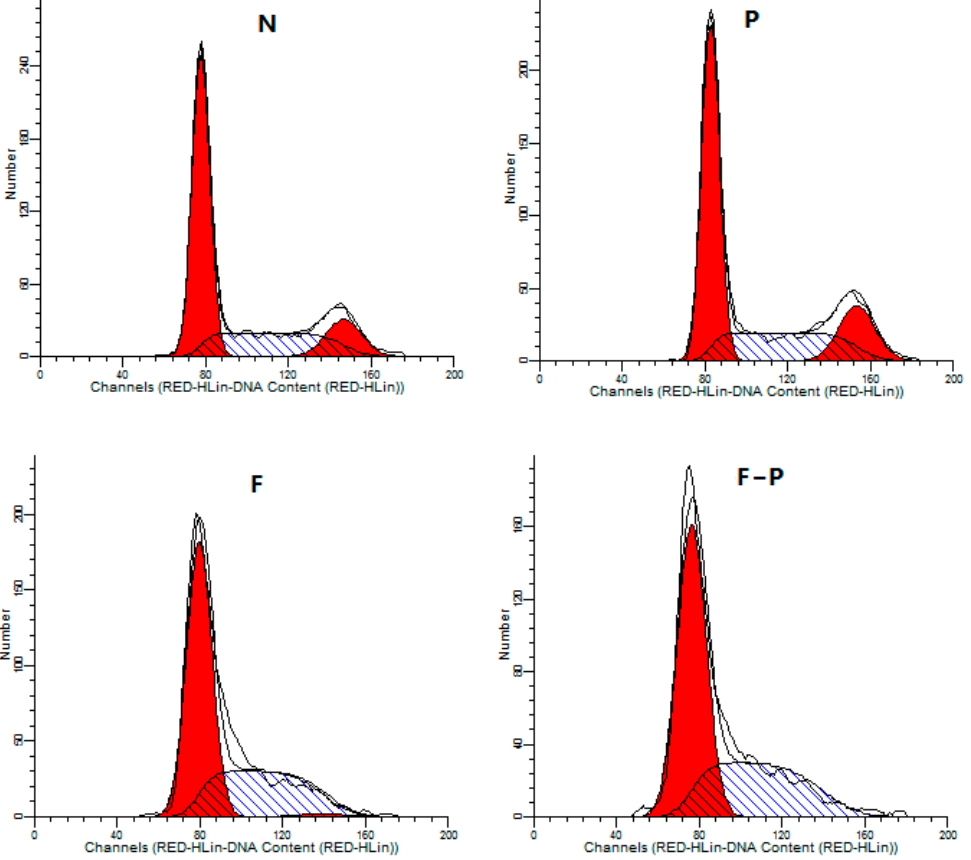
Figure 6. Cell cycle effects of 5-FU and PHA in HepG2 cells after 24 h exposure.